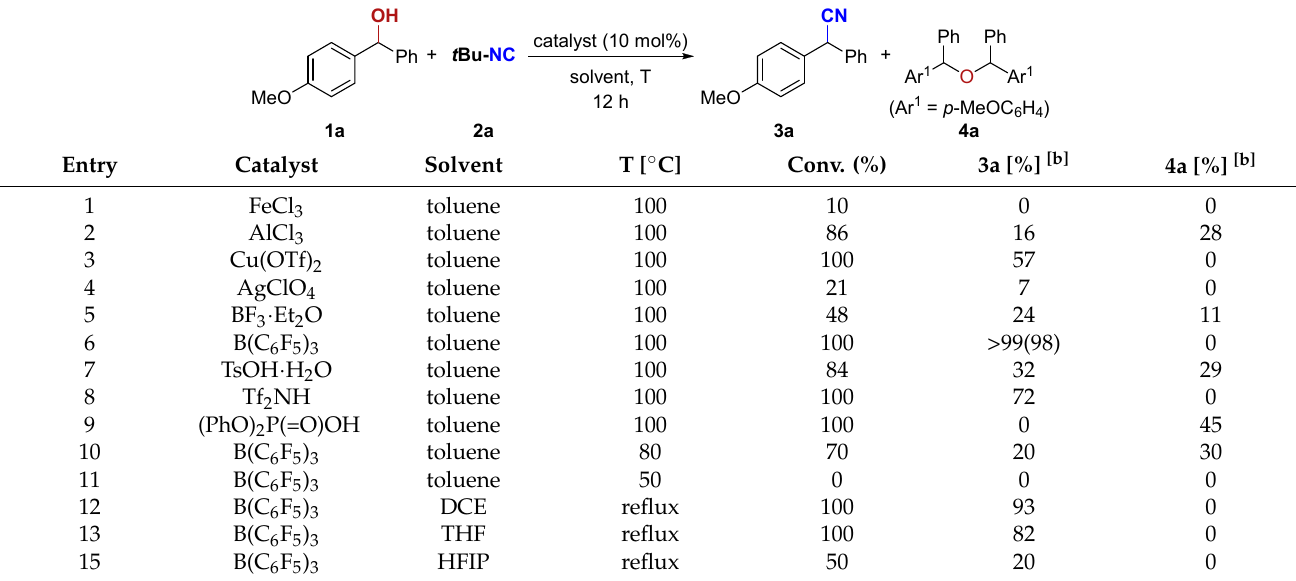
Table 1. Optimization of reaction conditions [a]